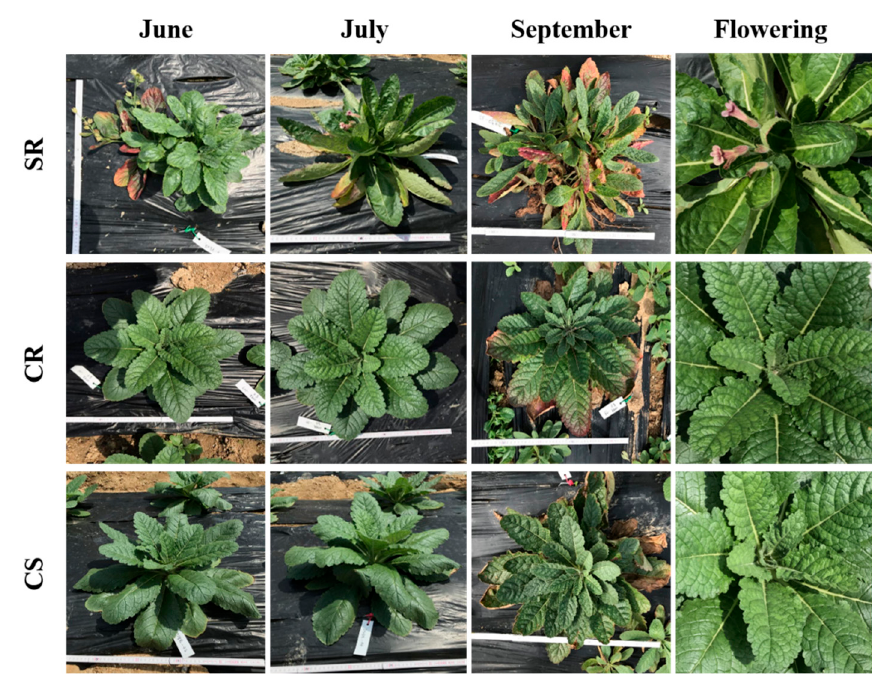
Figure 1. Comparison of the development and flowering of the aerial parts of the three types of R. glutinosa seedlings. SR, standard rootstock seedling. CR, culture rootstock seedling. CS, culture seedling.